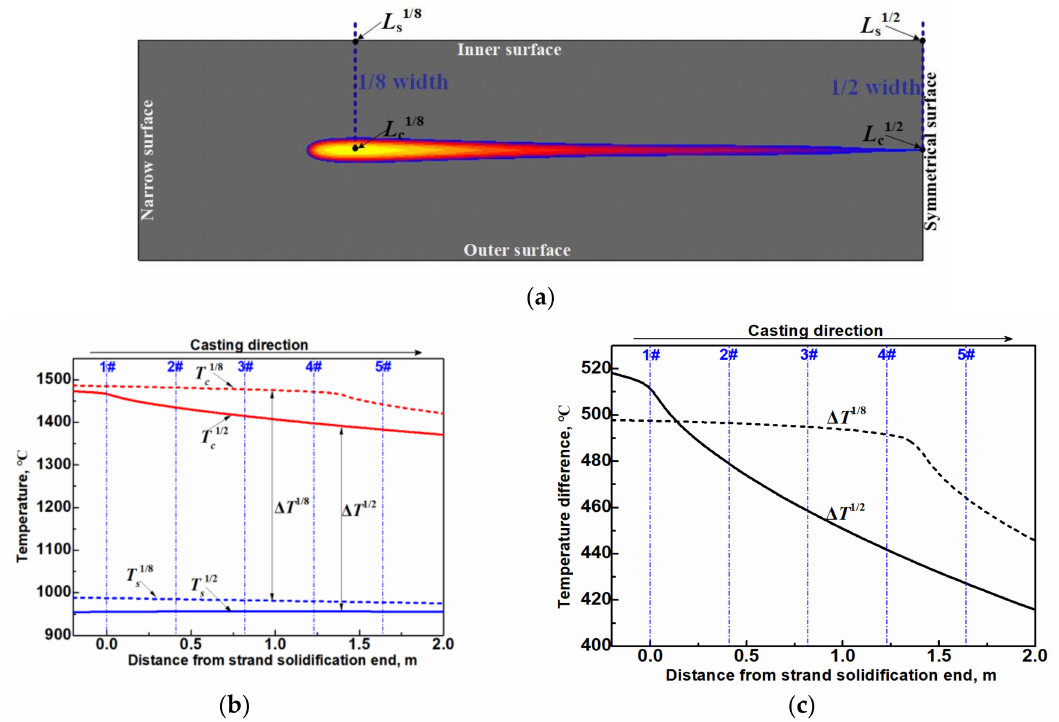
Figure 12. ( a ) Distribution of the typical locations on the slab transverse section and variation of the ( b ) temperature and ( c ) temperature difference at the typical locations during